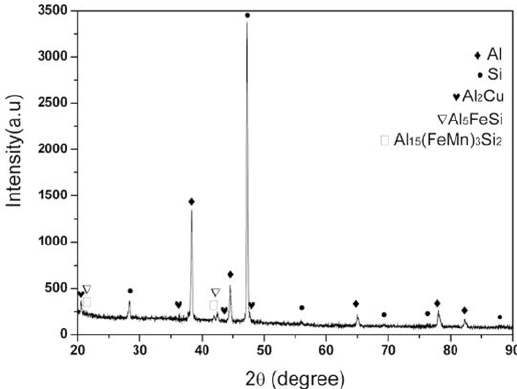
Figure 7 details the microstructure of the sample submitted to solution treatment at 540 o C/6h and ageing at 190 o C/4h.